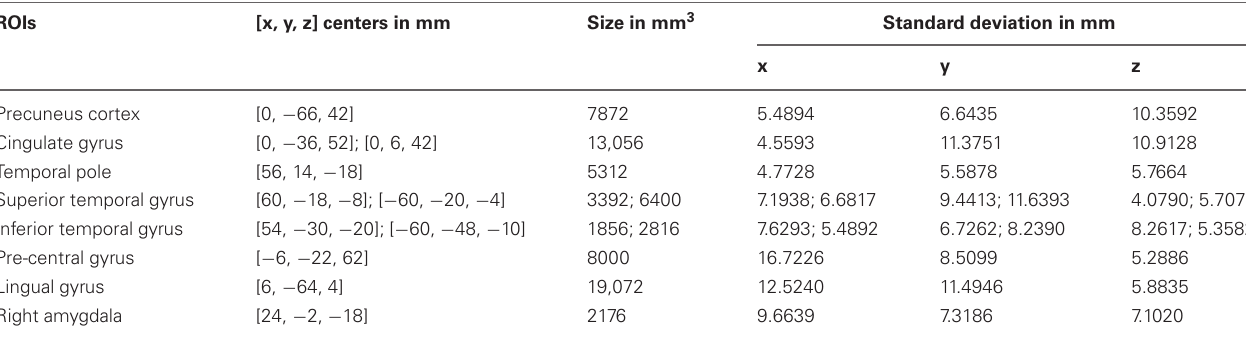
Table 2 | Shows list of the clusters and their approximate centers, sizes and standard deviations found using the most useful region mask